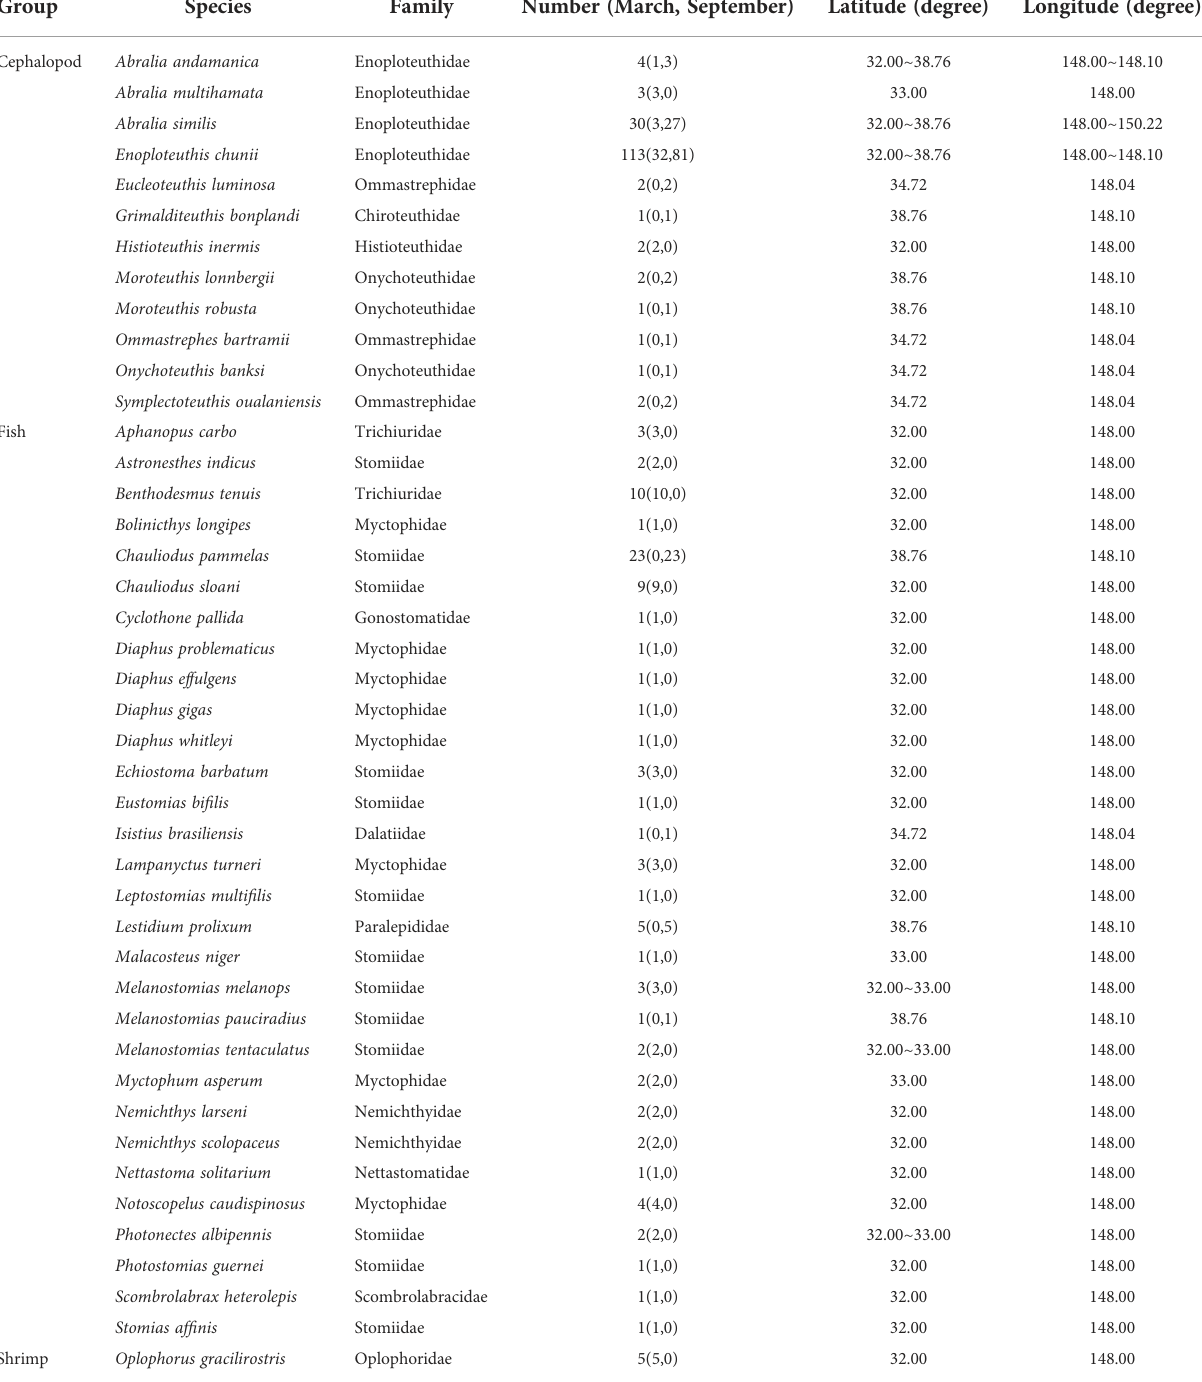
TABLE 1 Sampling information of